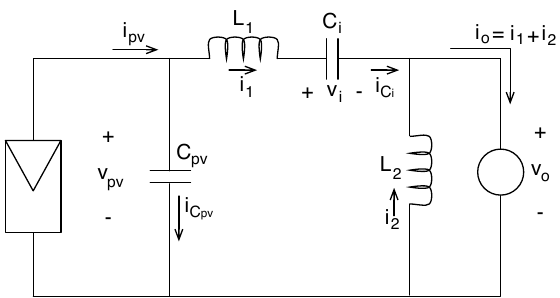
Figure 3. Topology 0 of the PV system based on the CIOC buck